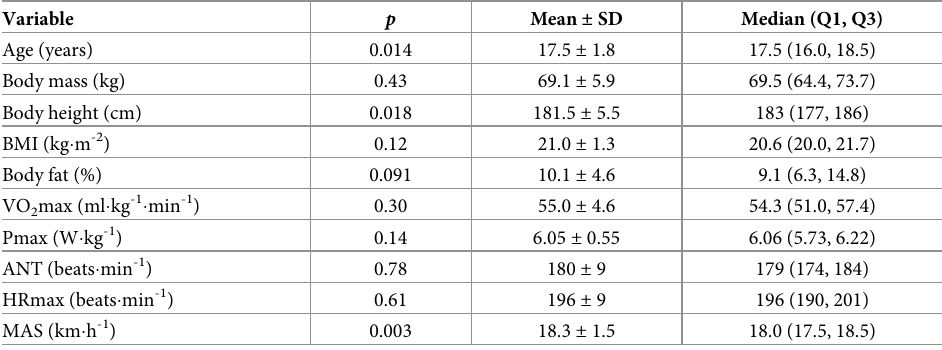
Table 1. Characteristics of the runners (n = 24).